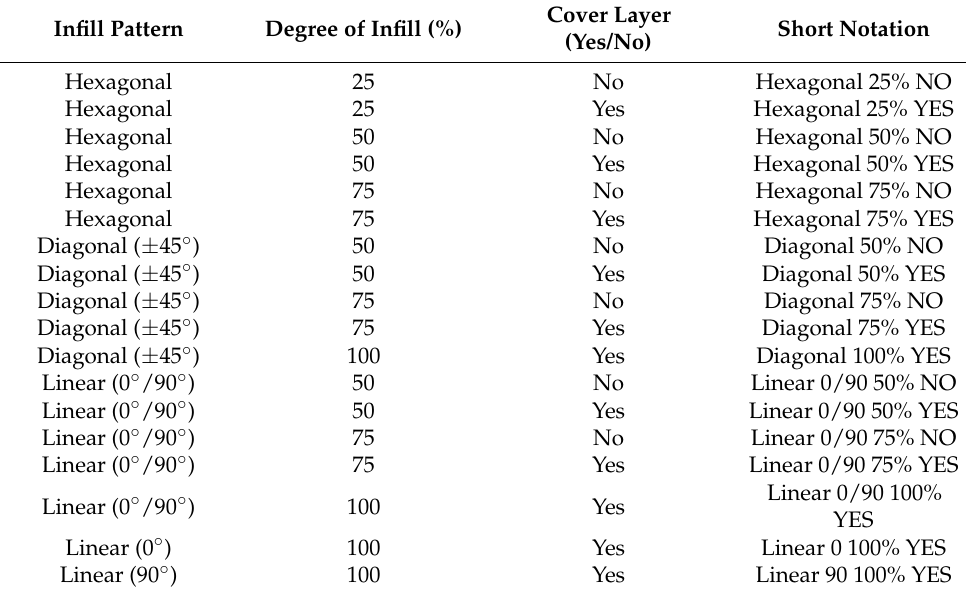
Table 1. List of the various specimen